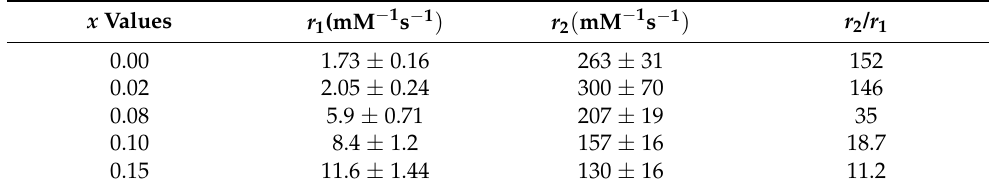
Table 2. Longitudinal r 1 and transverse r 2 relaxivities of EuMZF nanoparticles with different Eu substitutions.